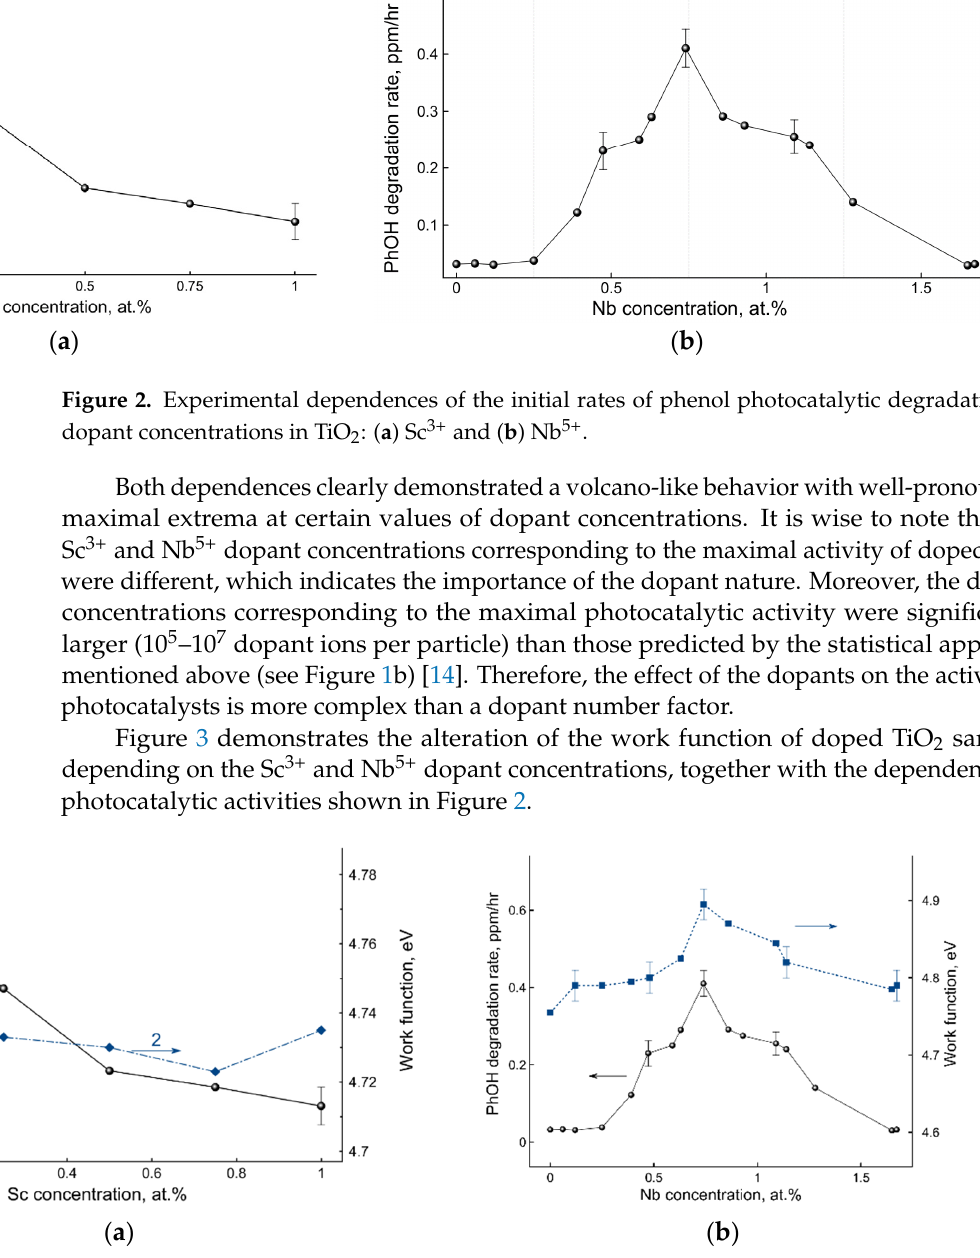
Figure 3. Dependences of the photocatalytic activities (curves 1, in black) and work functions (curve 2, in blue) of doped TiO 2 on dopant concentrations: ( a ) Sc 3+ and ( b ) Nb 5+ .